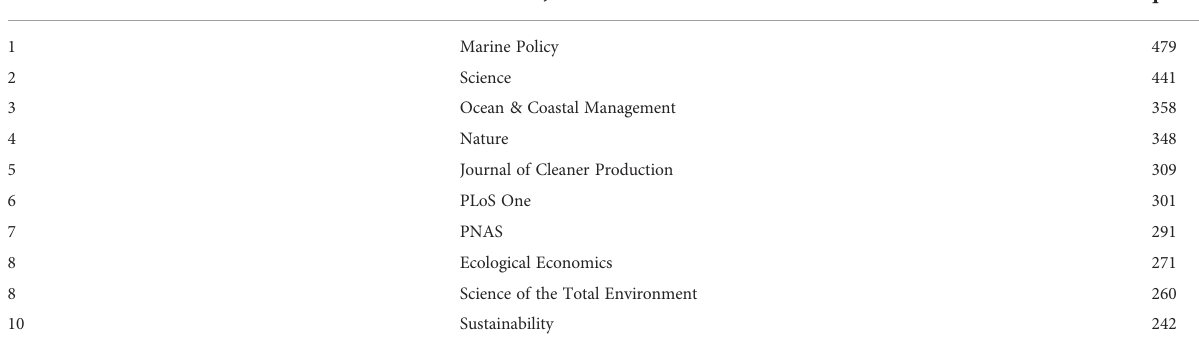
TABLE 7 The top 10 cited journals based on frequency from 2006 to 2021.